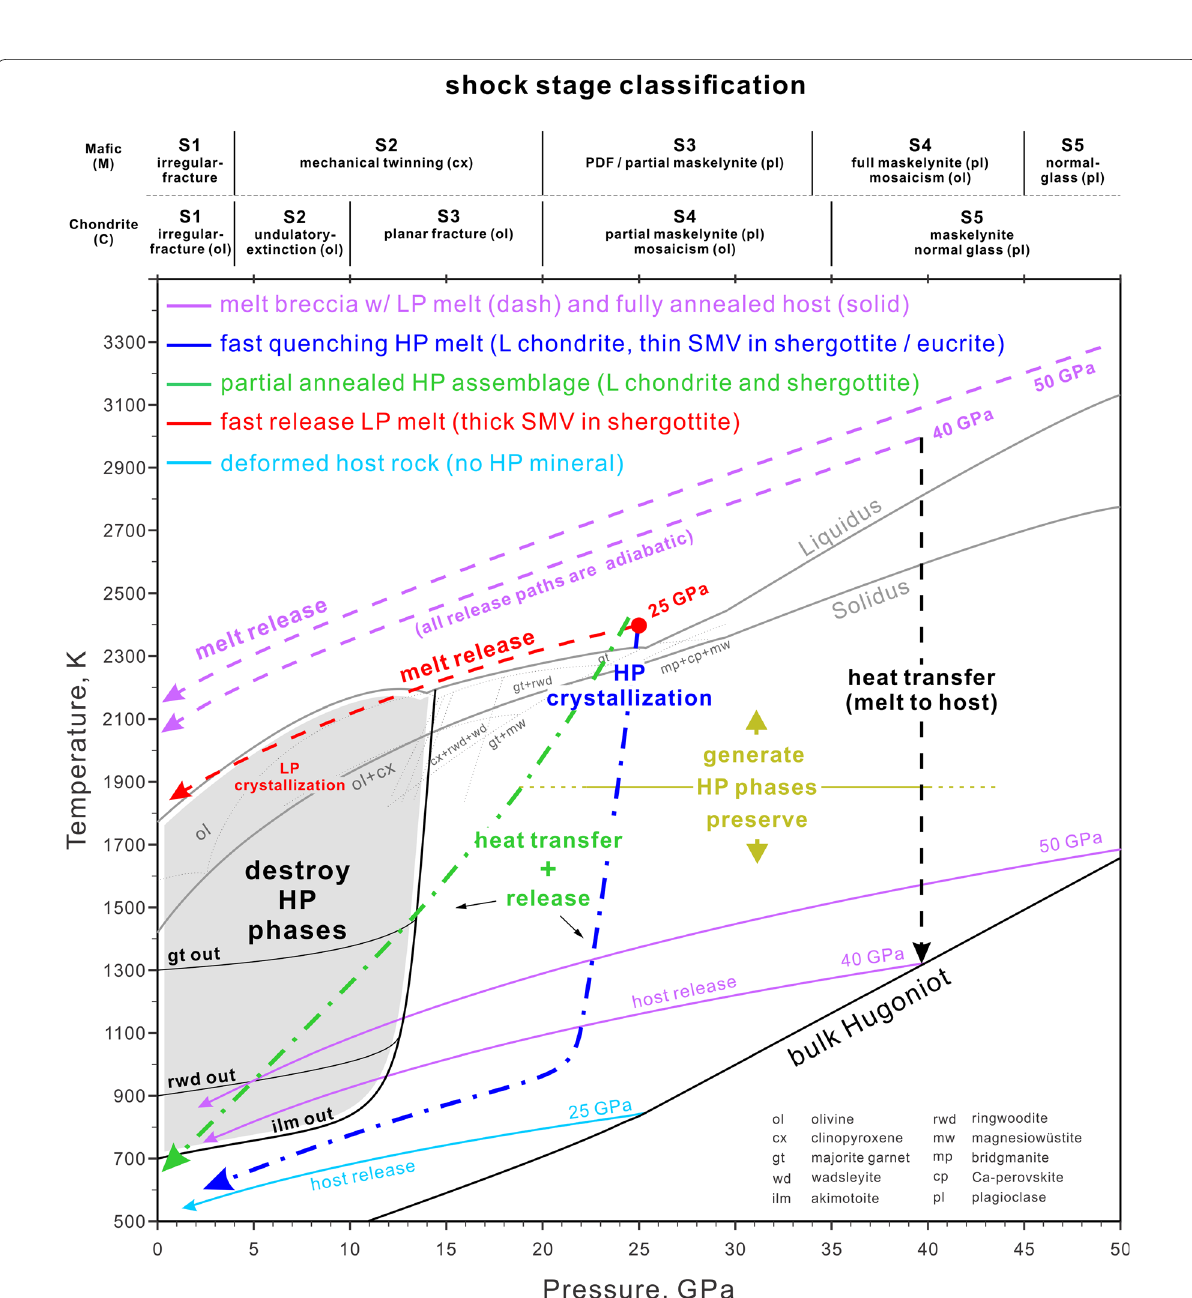
Fig. 7 The cooling paths of typical moderately to highly shocked meteorites. The adiabatic release paths (cyan, red and purple lines) are from Fig. 5. HP and LP melt refer to shock melt that crystallizes before and after pressure release, respectively. The vertical line represents pure heat transfer from shock melt veins (SMV) to solid groundmass without synchronous pressure drop by decompression. The dark yellow line shows the approximated temperature of triggering rapid HP transformation. The grey area represents the conditions for destruction of akimotoite (ilm), ringwoodite (rwd) and garnet (gt) by amorphization or back transformation. The blue and green lines represent combinations of decompression and synchronous heat-transfer, where blue corresponds to rapid thermal quench with crystallization at high pressure and green corresponds to a greater contribution for decompression, resulting in crystallization at slightly lower pressure and partial annealing in the grey area. The shown P–T paths are technically for chondritic/ultramafic rocks but the concepts also work for mafic rocks. The top x-axis shows shock stage classification with deformation features of chondrite (C) and mafic meteorite (M) such as basaltic shergottite (Stöffler et al. 1991,